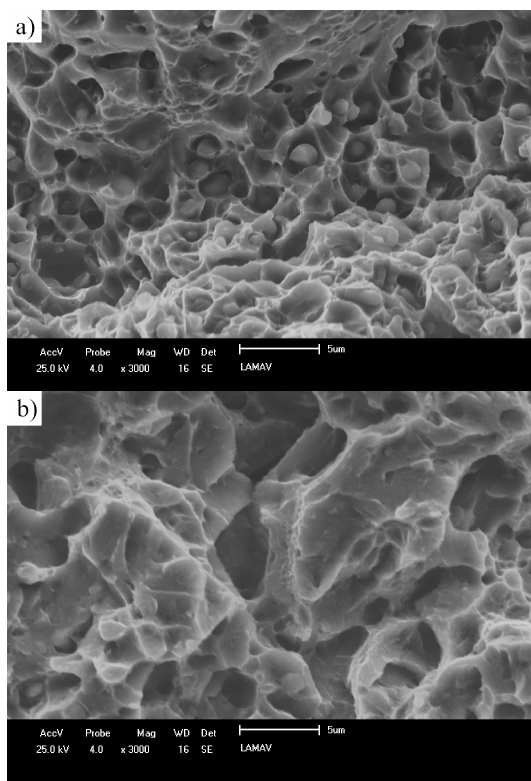
Figure 11. Scanning electron microscopy images of the fracture surface near (a) and far (b) from the notch tip in two different specimens (magnification of 3000×).